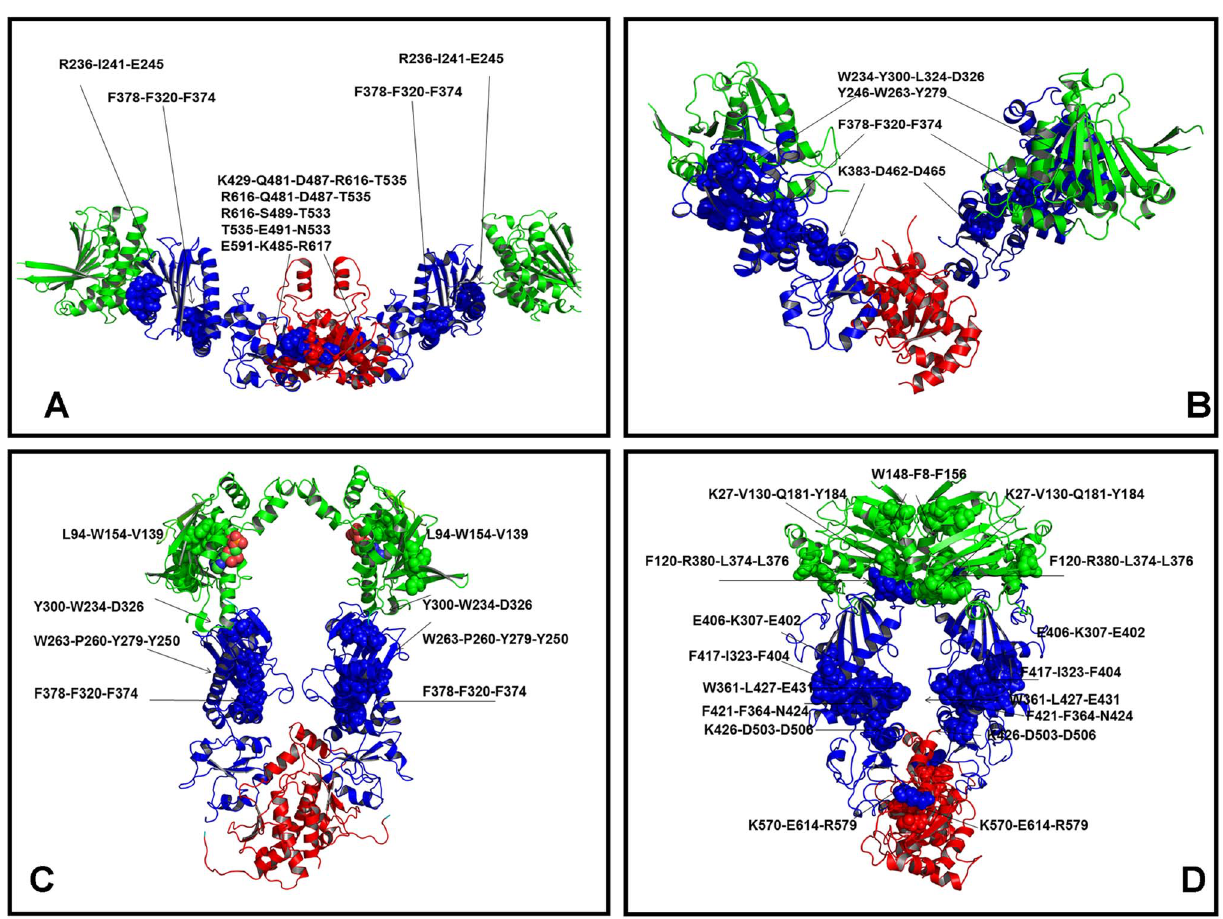
Figure 8. Structural Maps of Stable Interaction Communities in the Hsp90 Structures. The distribution of structurally stable interaction communities is shown for the SAXS structure of HtpG (A); the crystal structure of apo HtpG (B); the crystal structure of ADP-HtpG (C); and the crystal structure of yeast ATP-Hsp90 (D). The Hsp90 structures are shown in a ribbon representation and colored according to their domain nomenclature: Hsp90-NTD (in green), Hsp90-MD (in blue), and Hsp90-CTD (in red). The Hsp90 residues that constitute structural communities are shown in spheres and colored according to their respective domains. The residue-based annotation of stable communities is provided and structural positions of communities are indicated by arrows. Structural mapping of stable communities in the solution HtpG structure (A) and ADP-HtpG structure (C) shows a partly disjointed pattern of the interaction networks that are mostly confined within the individual domains. The ATP-bound dimer of yeast Hsp90 has a dense interaction network that includes both the inter-domain and the inter-monomer communities. The Pymol program was used for visualization of the Hsp90 structures (The PyMOL Molecular Graphics System, Version 1.2r3pre, Schro¨dinger, LLC).